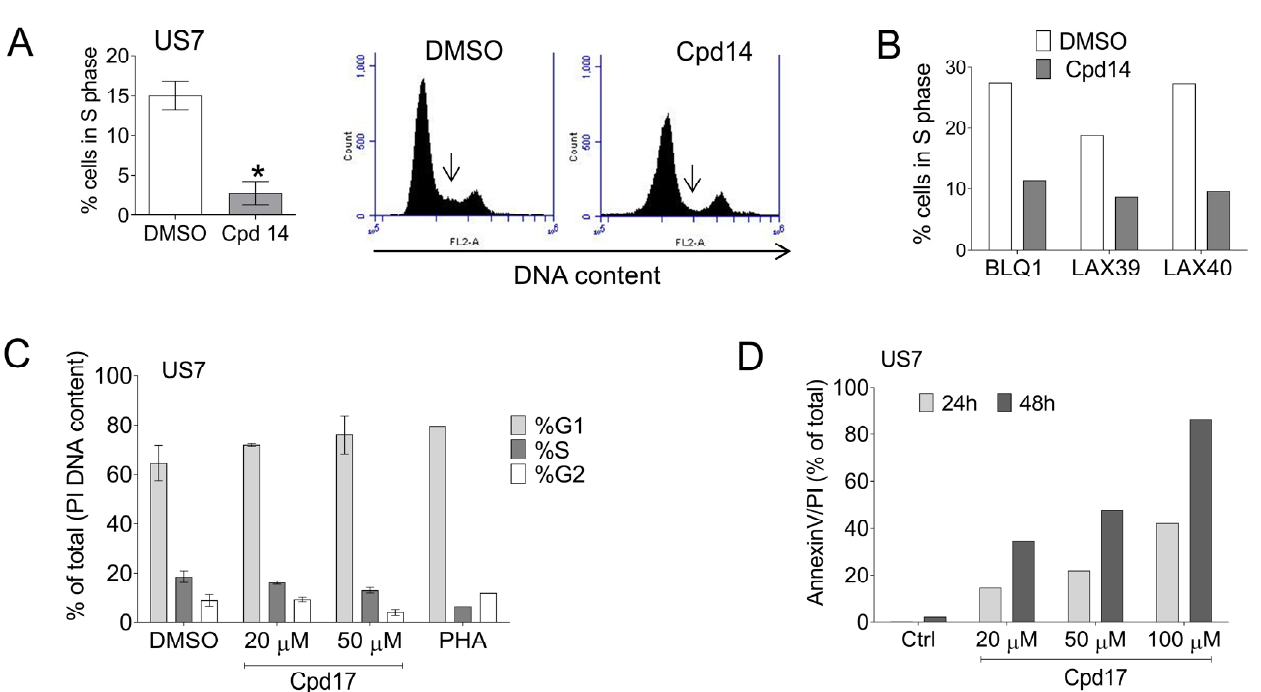
Figure 6. Analysis of effects of Cpd14 and 17 on cell cycle and apoptosis. ( A ) Cell cycle of US7 cells measured by DNA PI staining using FACS, following 48 h exposure to 250 μ M Cpd14. Left: percentage of BCP-ALL cells in S phase; Right: representative image, arrow points to S phase DNA content. Error bars, mean ± SEM of duplicate measurements. * p < 0.05, unpaired t -test, two-tailed. ( B ) Percentage of BCP-ALL cells as indicated in S phase after 48-h treatment with 250 μ M Cpd14. Single samples, 3 different BCP-ALLs. ( C ) Cell cycle analysis on US7 cells treated with Cpd17 using FACS and PI DNA staining. Duplicate measurements, 2-way ANOVA, differences not significant. PHA, 1 µ M PHA-739358 (danusertib), single sample. ( D ) Percentage of apoptotic US7 cells based on AnnexinV/PI positivity after treatment with Cpd17.